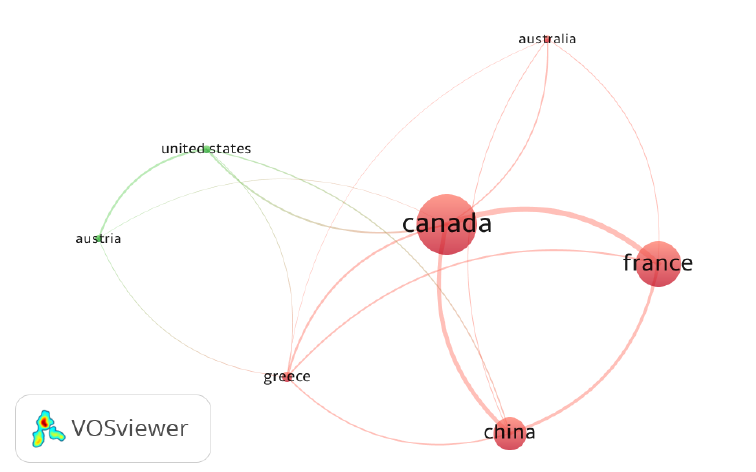
Figure 3. Top-7 bibliographic couplings between countries.